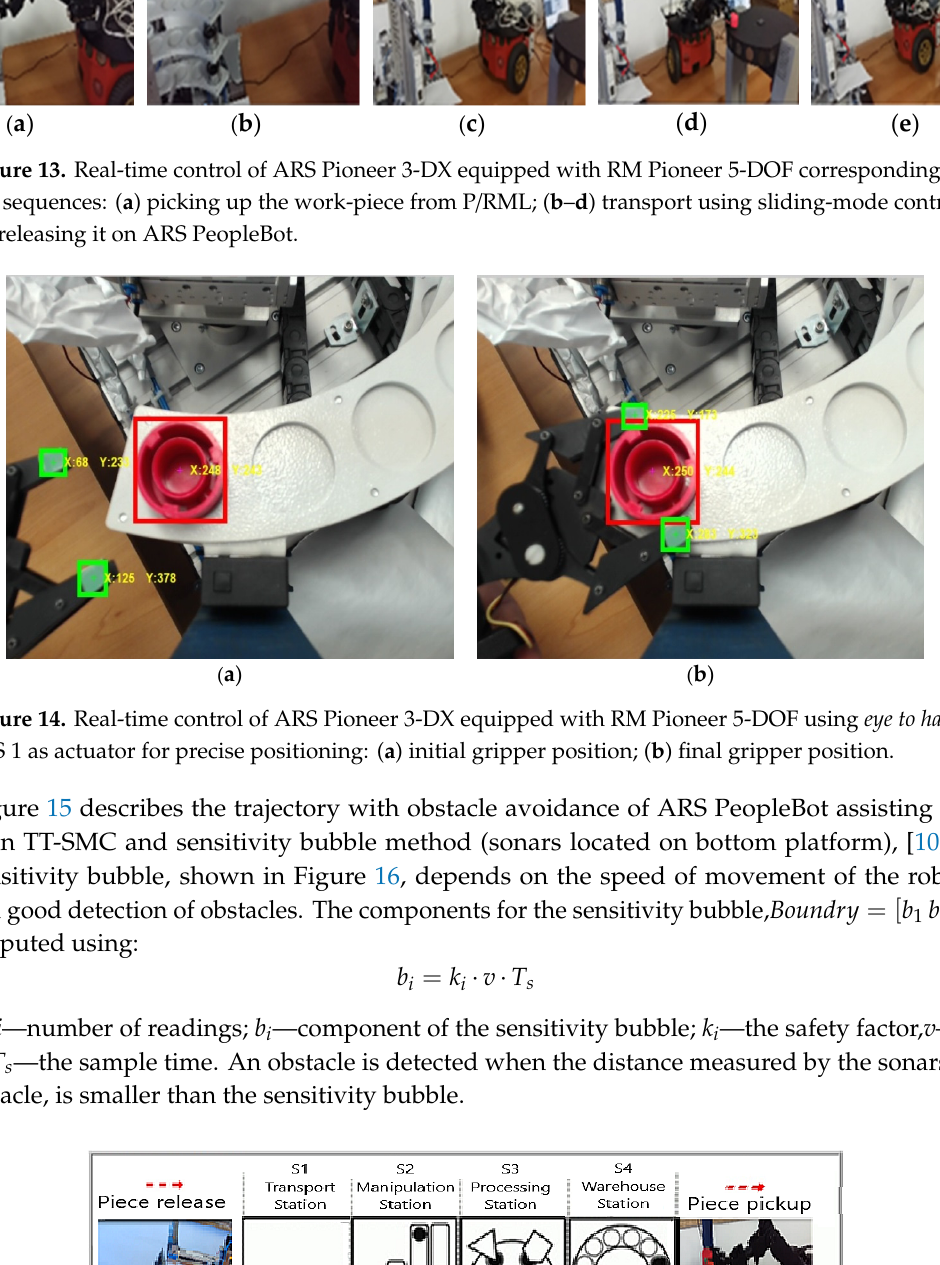
Figure 16. Detection area of the sonars and the sensitivity bubble. Figure 17. Detour path to avoid the obstacle. Figure 20 shows the real-time control of RM Cyton based on invers kinematics, [20], eye in hand and eye to hand VSS for handling the work-piece: in the left initial position, in the middle, caching the work-piece from ARS PeopleBot, in the right, releasing the work-piece on P/RML.